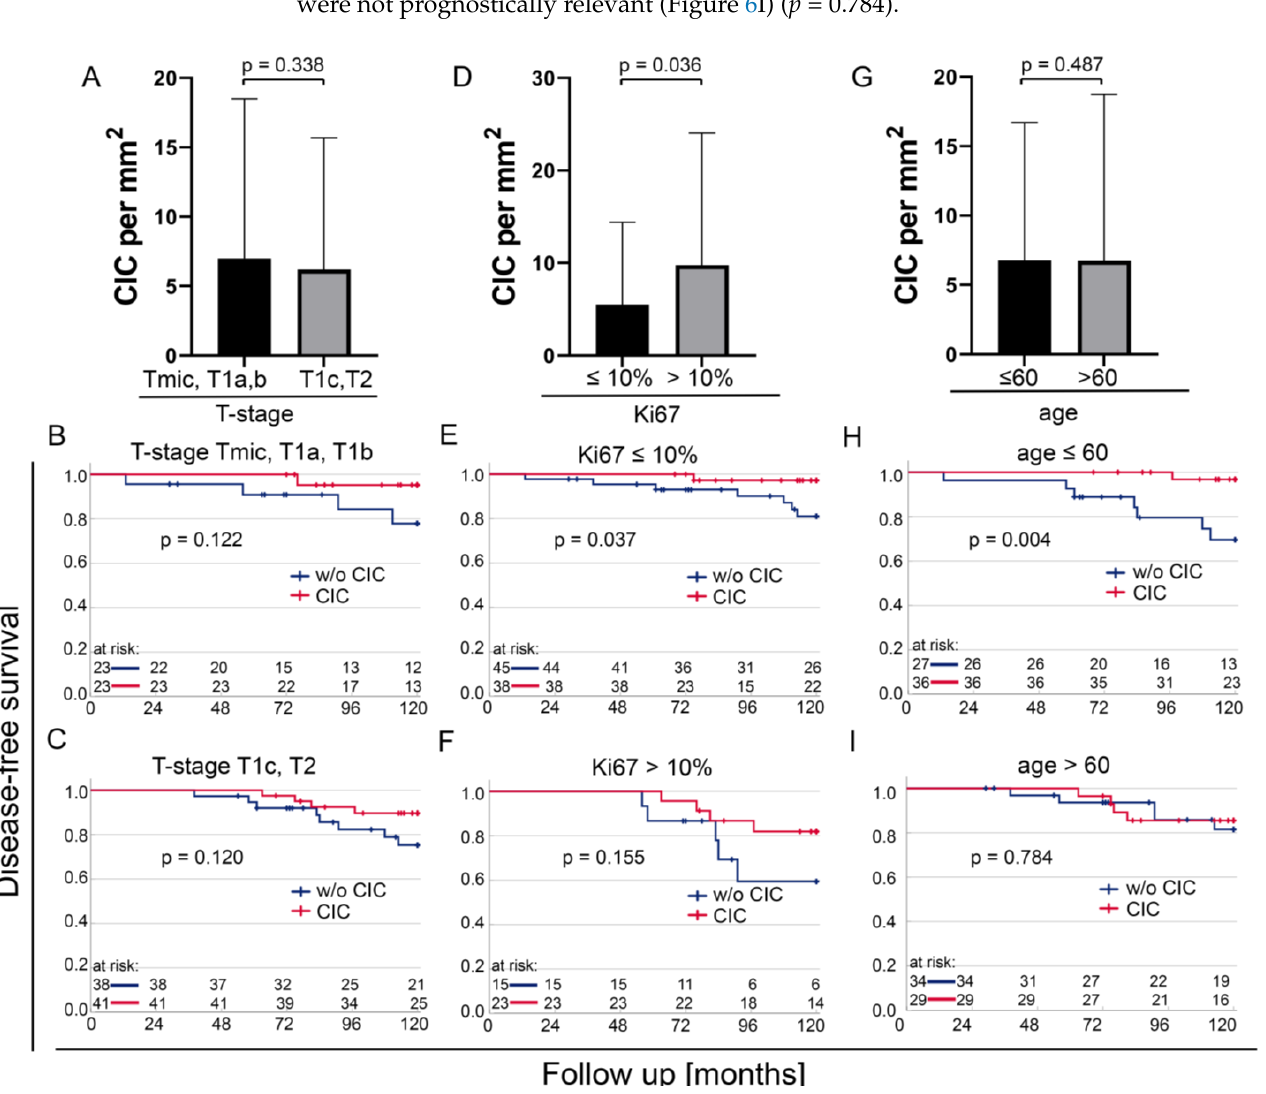
Figure 6. Prognostic value of cell-in-cell (CIC) in different subgroups. ( A ) CIC per mm 2 in the group comprising pTmic, pT1a, and pT1b compared with the group comprising pT1c and pT2 and the importance of CIC rates in the ( B ) pTmic, pT1a, pT1b subgroup and ( C ) pT1c, pT2 subgroup. ( D ) CIC per mm 2 in tissues with Ki67 ≤ 10% compared with Ki67 > 10% and the prognostic significance of CIC rates in the subgroups of ( E ) Ki67 ≤ 10% and ( F ) Ki67 > 10%. ( G ) CIC per mm 2 in patients 60 years of age or younger compared with patients older than 60 years, and the prognostic significance of CIC rates in the subgroup ( H ) A ge ≤ 60 years and the subgroup ( I ) Older than 60 years.